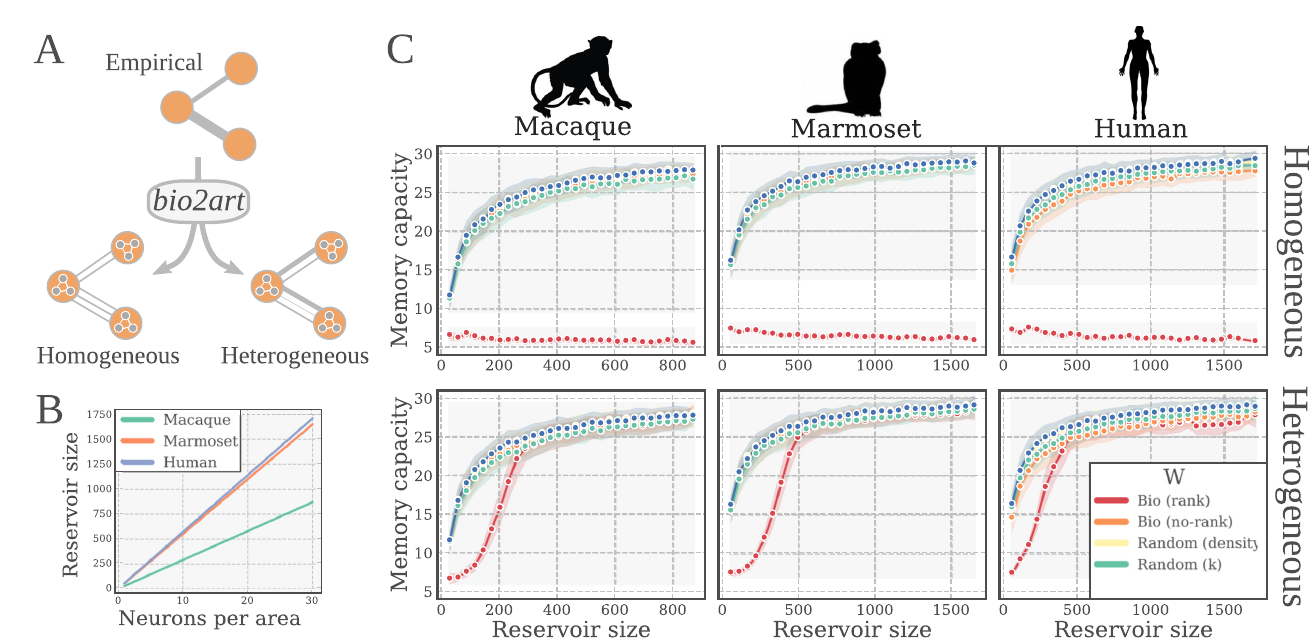
Fig 5. Scaling of performance with reservoir size. ( A ) Scaling up empirical connectomes with bio2art . Scaling allows to specify a number of neurons per area (brain region as defined in the connectome). The interareal weights might be mapped either homogeneously or heterogeneously. Homogeneous mapping partitions total weights in equal parts amongst interareal connections. Heterogeneous mapping partitions total weights at random amongst interareal connections. ( B ) Relationship between the neurons per area and the total reservoir size for all the studied scaling factors. ( C ) Performance of BioESNs with scaled up connectomes on the memory capacity task, for heterogeneous and homogeneous interareal connectivity patterns (upper and lower row, respectively). For each single condition (size, interareal connectivity), 100 different networks with newly instantiated weights were trained (4000 time steps) and tested (1000 time steps). The curves depict the test performance mean and standard deviation across